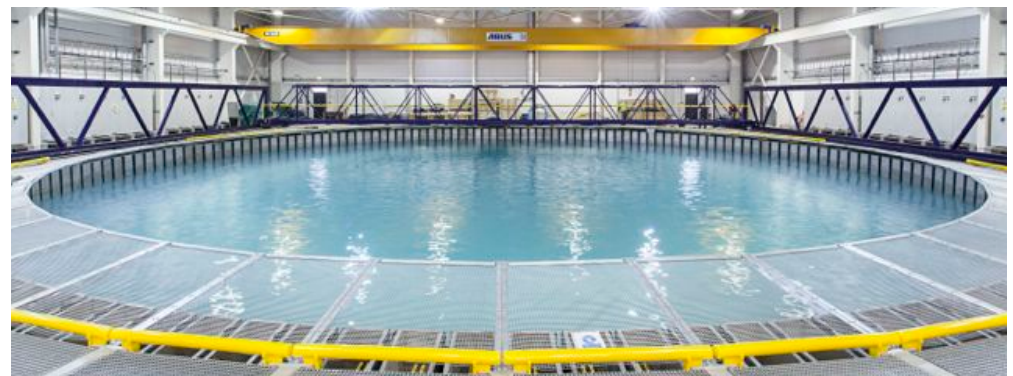
Figure 1. The Flowave Ocean Energy research facility - a circular wave and current test tank of 25 m diameter and a working depth of 2 m.